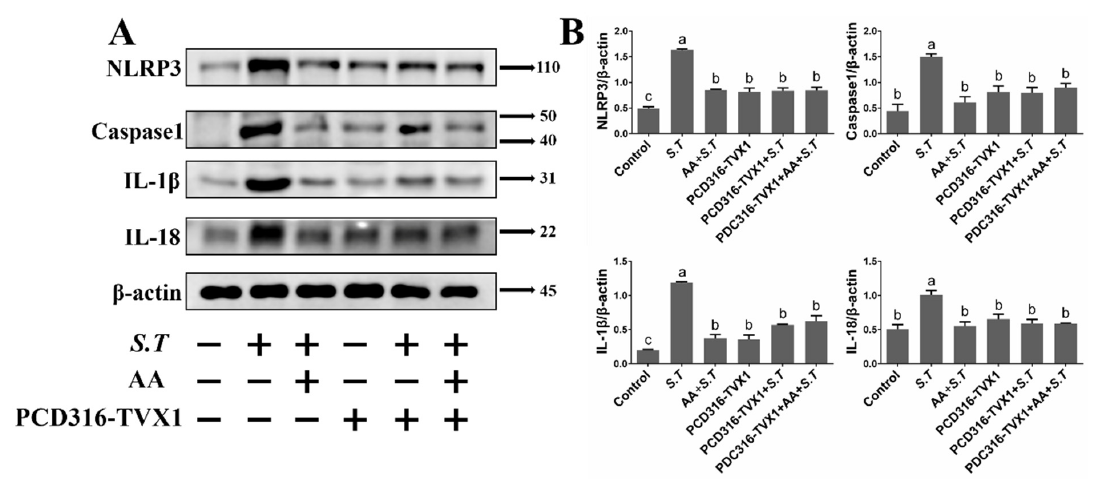
Figure 7. Effect of PCD316-TVX1 on AA Activation of the NLRP3 Inflammasome in S.T -Infected Microglia. Western blotting detection of NLRP3 inflammasome protein changes in microglia. ( A ) Microglia were transfected with PCD316-TVX1 plasmid. Twenty-four hours later, cells were pre-treated with AA for one hour, then infected with S.T , and proteins extracted for analysis. ( B ) NLRP3 inflammasome protein grayscale images (Different letters represent significant differences, p < 0.05, n = 3).